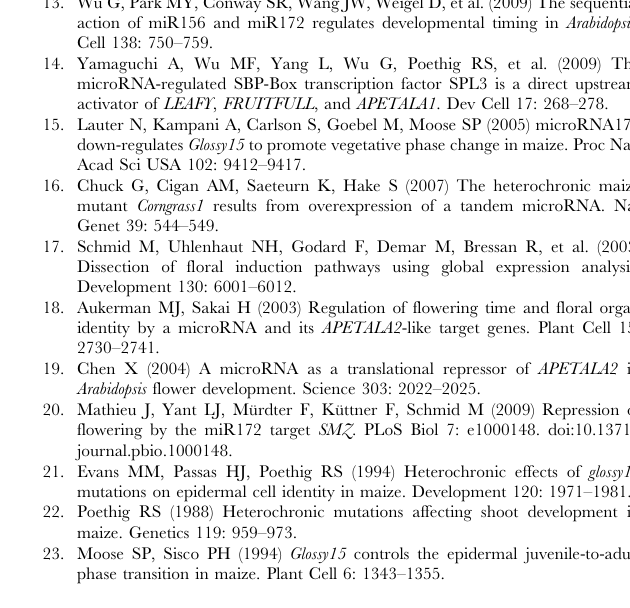
Table S2 Oligonucleotide primer